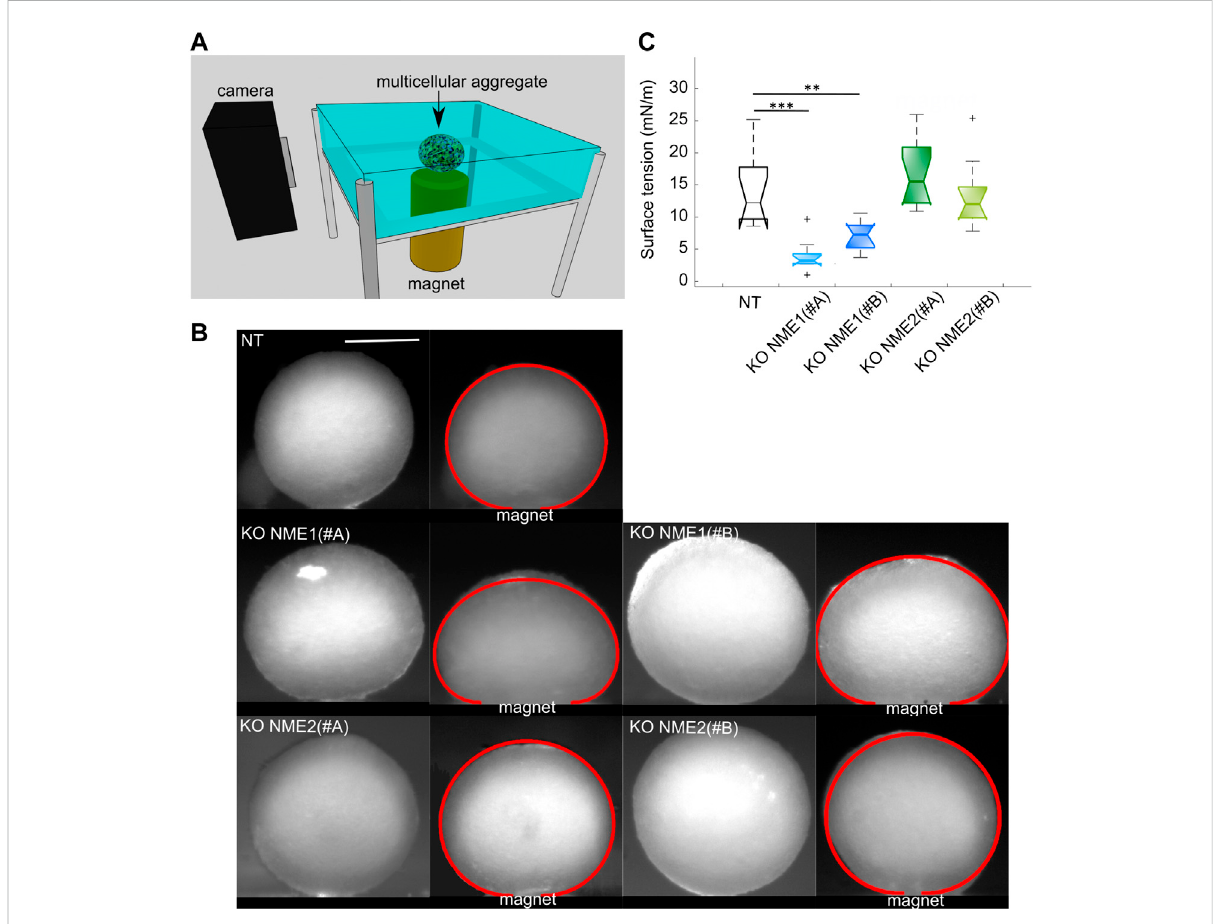
FIGURE 5 Surface tension is reduced after NME1 inactivation. (A) Magnetic tensiometer. A multicellular aggregate is seeded in a glass-side temperature- regulatedhomemadetank.Acamerarecordsitspro fi lefromthemomentapermanentmagnetisputincontactwiththebottomslideofthetank. (B) Representative side pro fi le images before and after the magnet approach for multicellular aggregates made from MCF10DCIS.com cells in which NME1 or NME2 was inactivated (scale bar: 500 μ m). Initial aggregates radii are of a comparable range. The obtained fi ts of the fl attened pro fi les are superimposed in red. Aggregates of NME1-ablated cells are more fl attened than aggregates of either NT or NME2-ablated cells. (C) Surface tension obtained from the different cell types presented in (B) . Median, standard deviation, and 95% interval of con fi dence are indicated. Each cell type ’ s measurements have been repeated over N = 3 independent experiments and over 9 – 15 multicellular aggregates. Only signi fi cant tests are indicated (** p < 0.01, *** p < 0.001). Results are compared to NT control